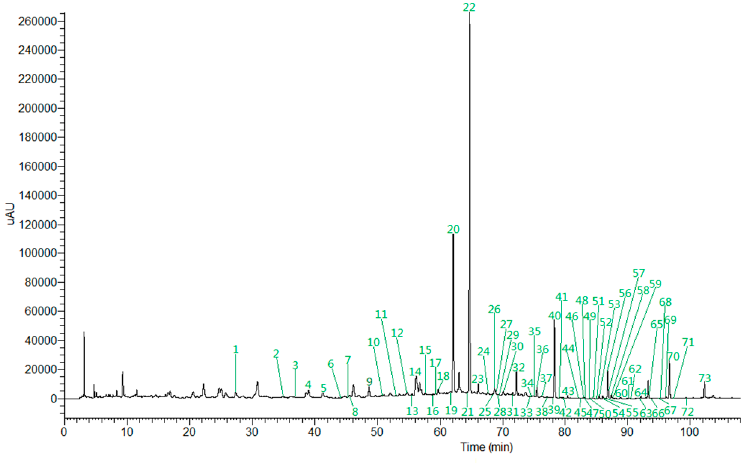
Figure 3. UHPLC chromatogram profiles of HWD.